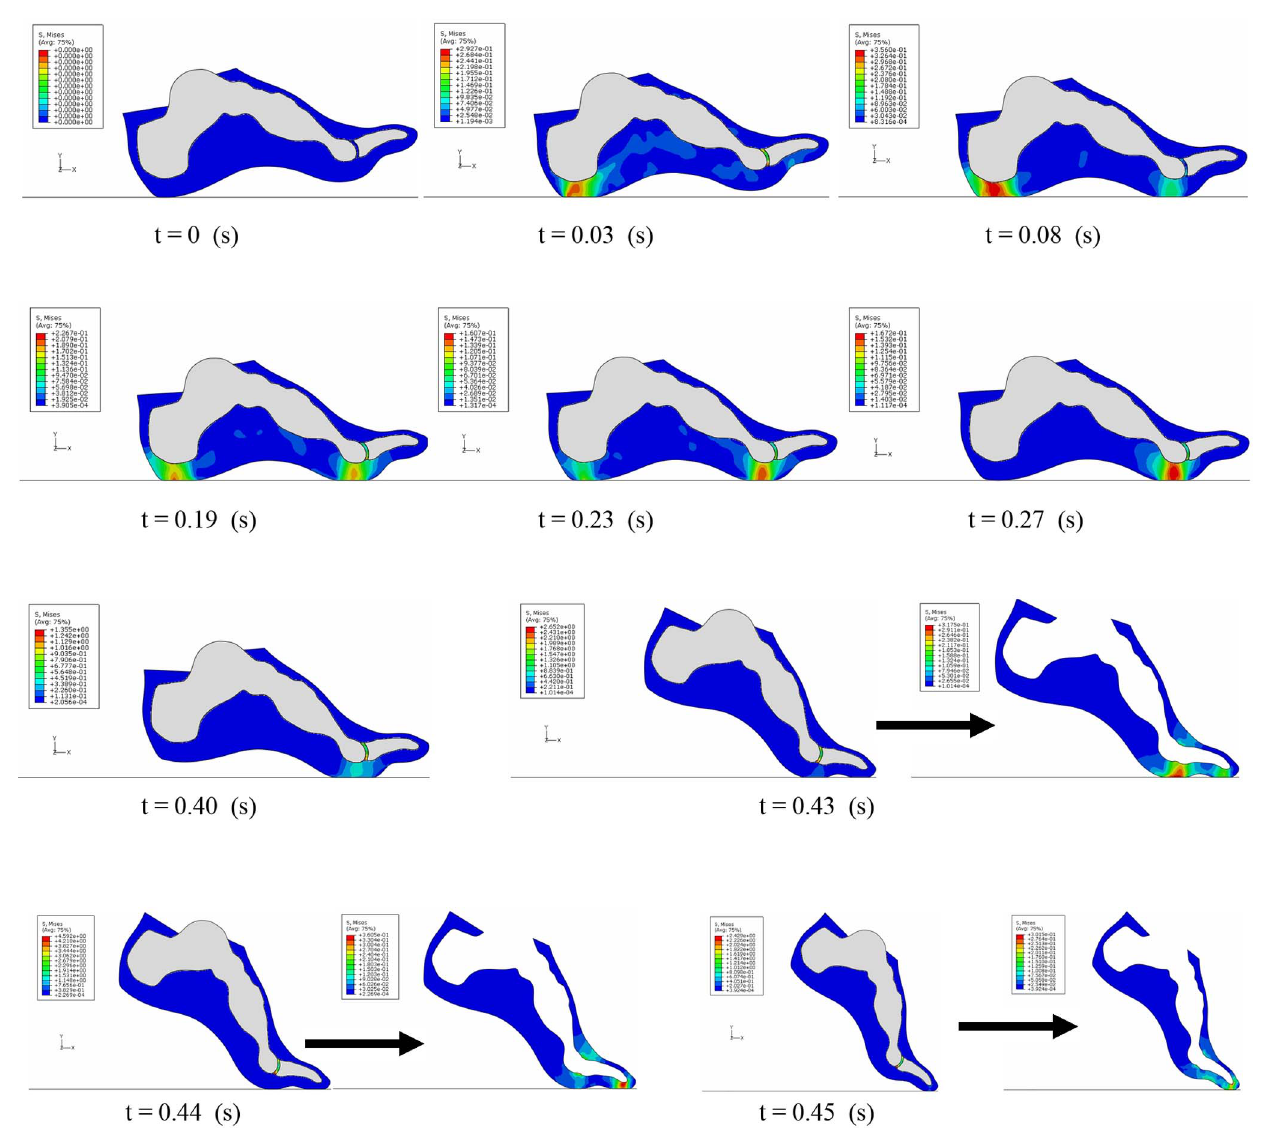
Figure 4. Predicted von Mises stress distribution at 10 representative instants of time over whole stance phase.